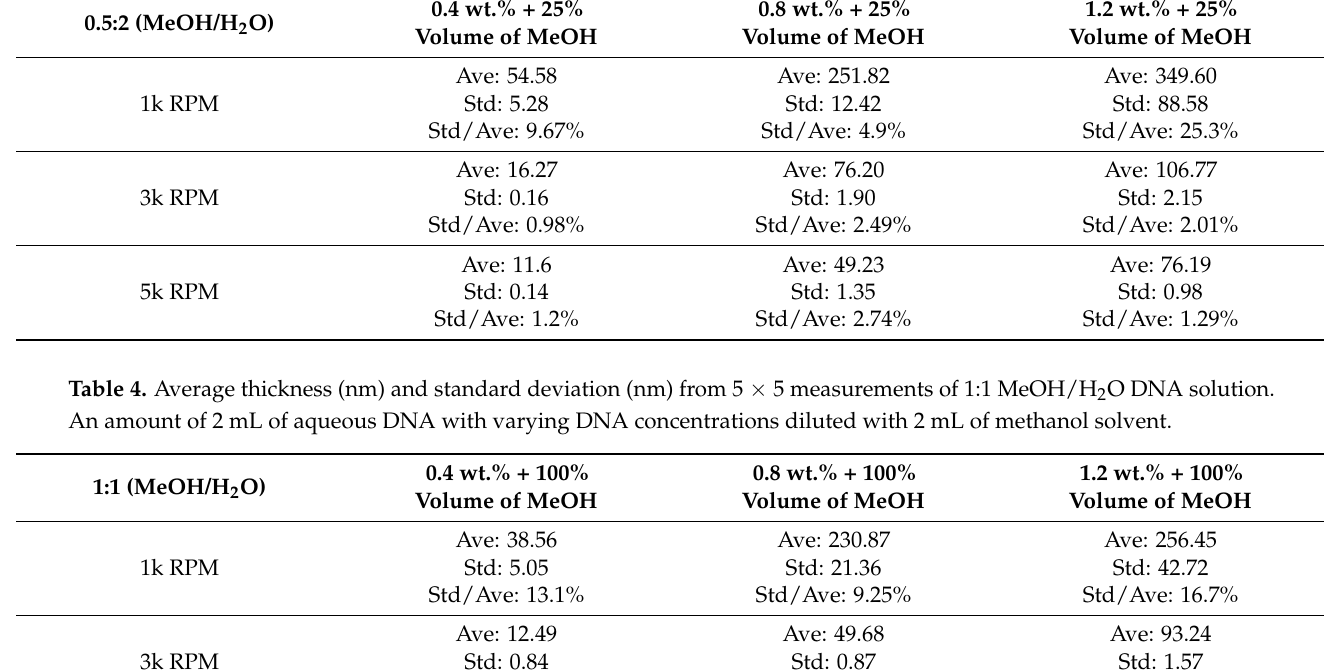
Table 3. Average thickness (nm) and standard deviation (nm) from 5 × 5 measurements of 0.5:2 MeOH/H 2 O DNA solution. An amount of 2 mL of aqueous DNA with varying DNA concentration solutions diluted with 0.5 mL of methanol solvent. 0.5:2 (MeOH/H 2 O)